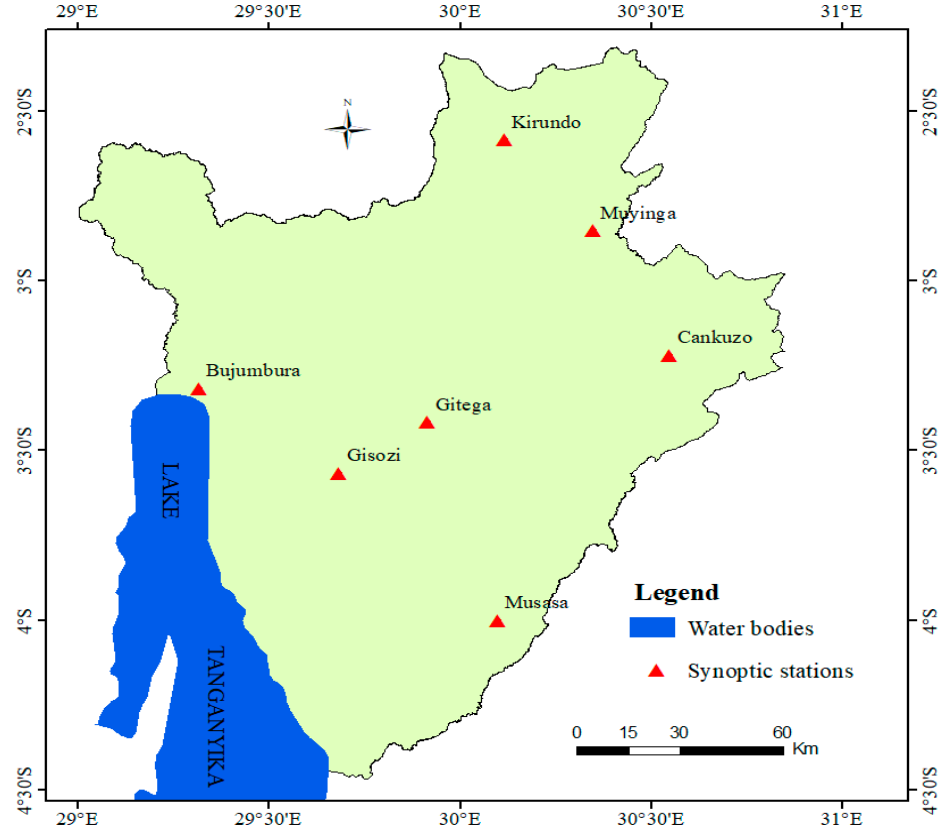
Figure 1. Map of Burundi and the distribution of meteorological stations used in the study.